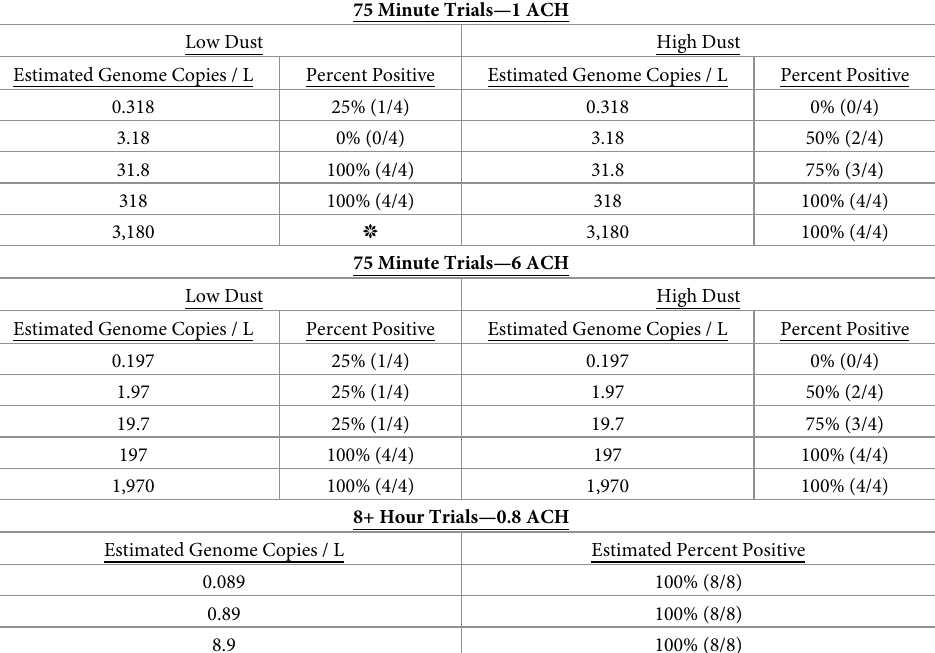
Table 6. Percent of media tested positive for the presence of SARS-CoV-2 RNA expressed as genome copied dosed per L of room air irrespective of time.